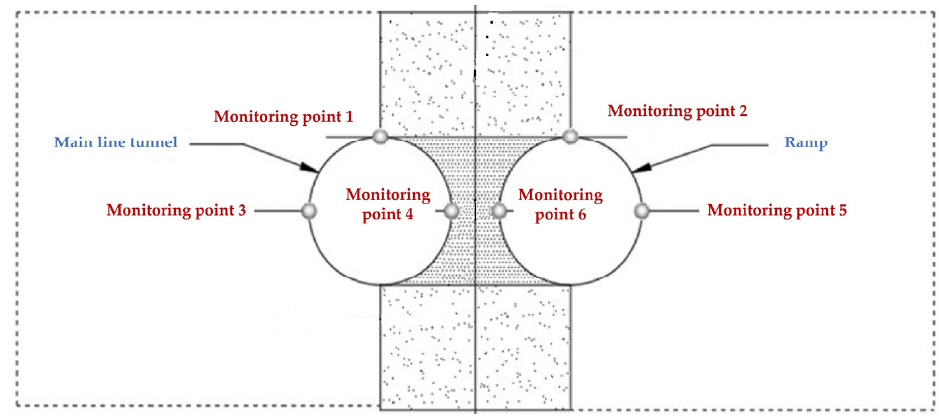
Figure 10. The specific measurement point layout.